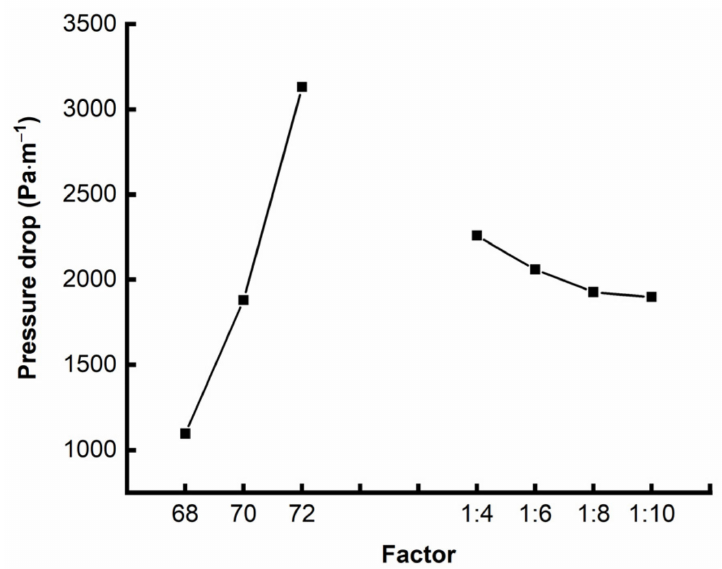
Figure 8. Influence of solid concentration and cement–sand ratio on pressure